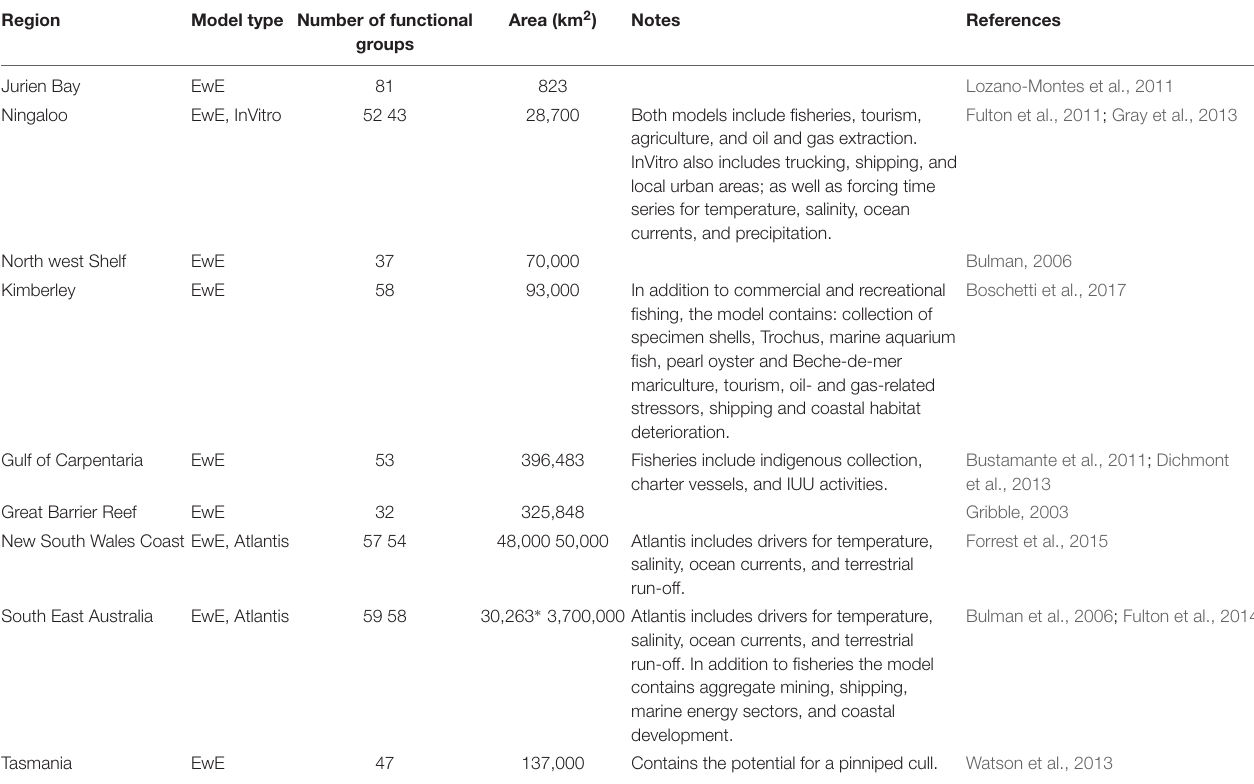
TABLE 1 | Details of the models used to investigate primary and indirect effects of extreme climate events. Region Model type Number of functional